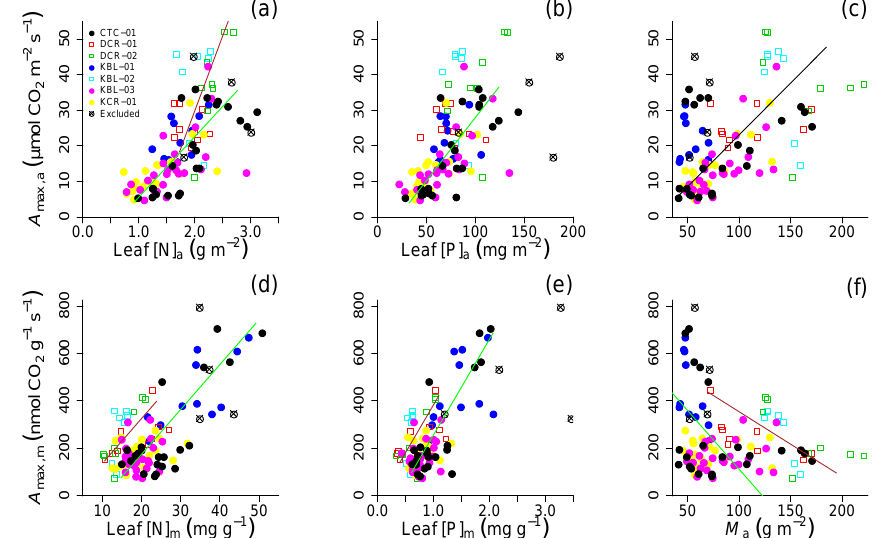
Figure 3. Top panels (plots a , b and c ): scatterplots of the area-based relationships between photosynthetic capacity ( A max , a ) and (a) leaf nitrogen, (b) leaf phosphorus, and (c) leaf mass per unit area ( M a ). Bottom panels (plots d , e and f ): the equivalent plots are expressed per unit leaf dried mass. Each point represents a single leaf; dots denote F sites and square symbols denote S sites; individual sites are distinguished by colour: CTC-01 black, DCR-01 red, DCR-02 green, KBL-01 royal blue, KBL-02 turquoise, KBL-03 pink, and KCR-01 yellow. SMA- fitted lines are shown where significant: F (green), S (brown). Pearson correlations testing the assumption of linearity are given in Table S4 together with likelihood ratio and Wald statistics testing the H 0 of common slope, elevation and axis shift for the two V classes. In plot (c) there was no difference in slope between the two V s and so a common line is fitted (black). SMA intercept, slope and r 2 values are given in